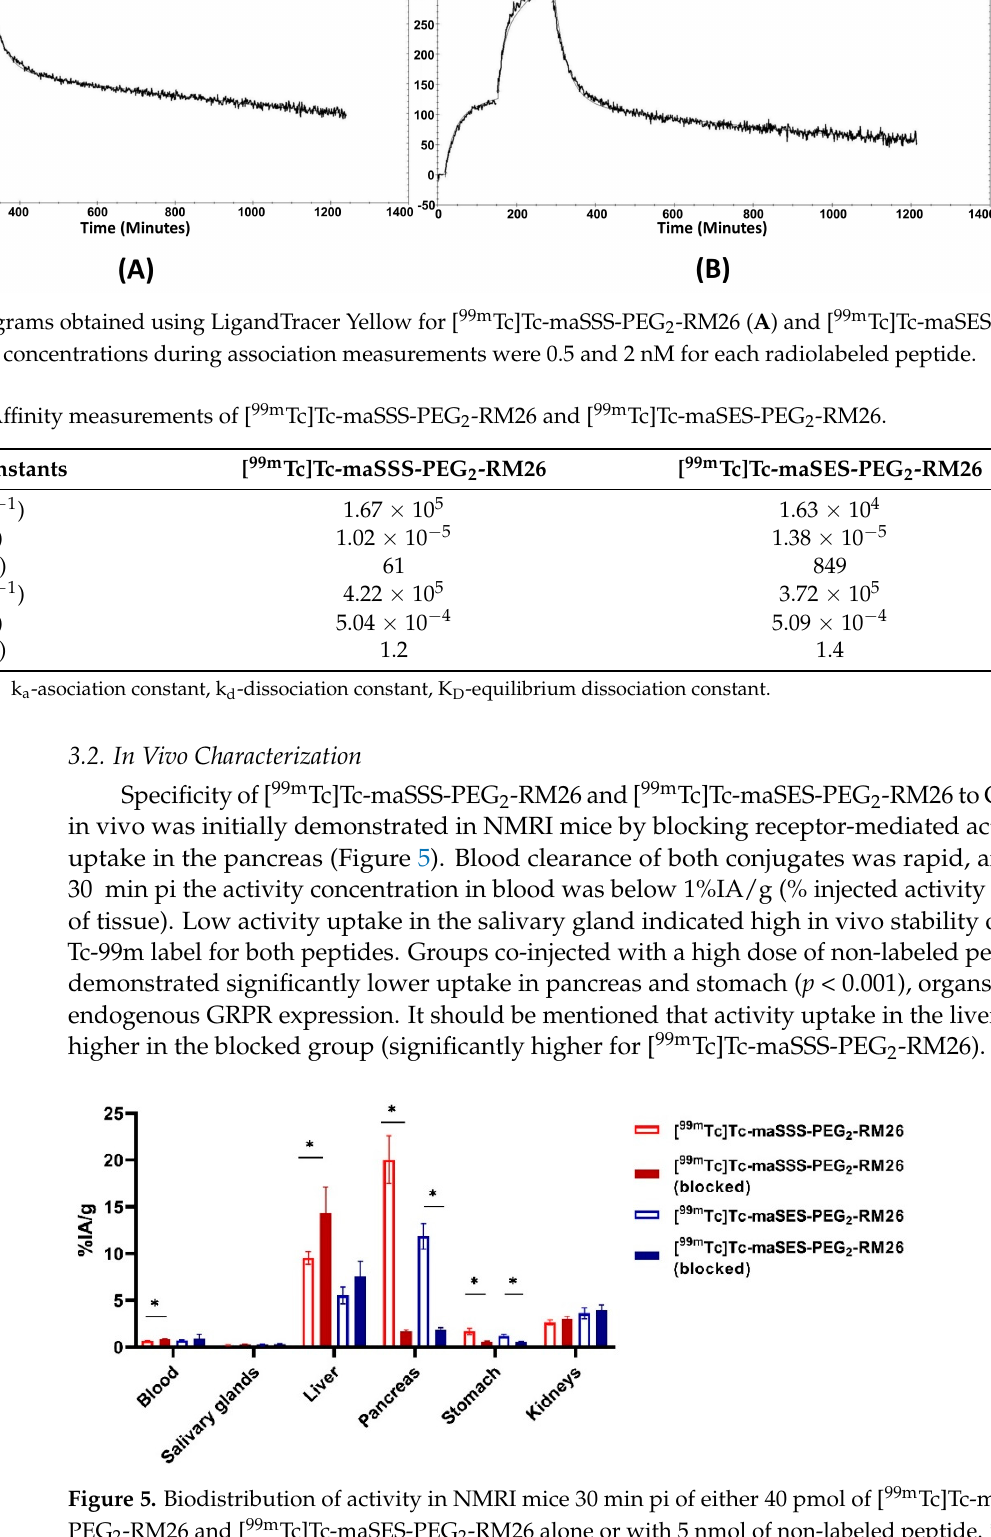
Figure 5. Biodistribution of activity in NMRI mice 30 min pi of either 40 pmol of [ 99m Tc]Tc-maSSS- PEG 2 -RM26 and [ 99m Tc]Tc-maSES-PEG 2 -RM26 alone or with 5 nmol of non-labeled peptide. * indi- cates a significant difference with a p- value <